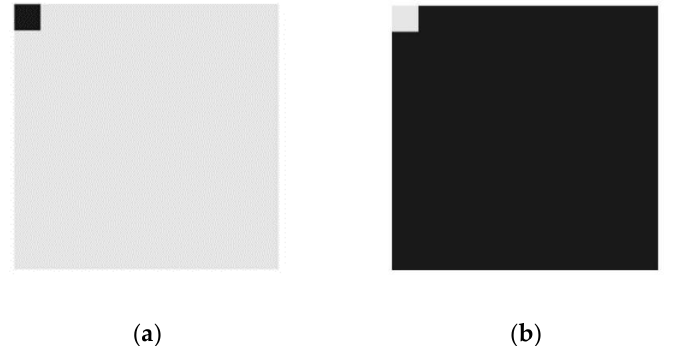
Figure 5. The filter is a logical matrix of the same size as the original image. The matrix element value of the gray part is 1, and the matrix element value of the black part is 0. ( a ) High − pass filter. ( b ) Low − pass filter. ( b ) Low − pass